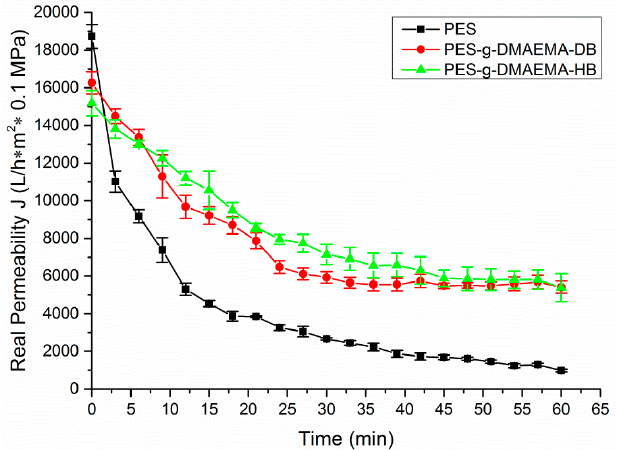
Figure 7. Fouling behaviors of various membranes during filtration of a bacteria solution (×10 5 CFU/mL, E. coli ).